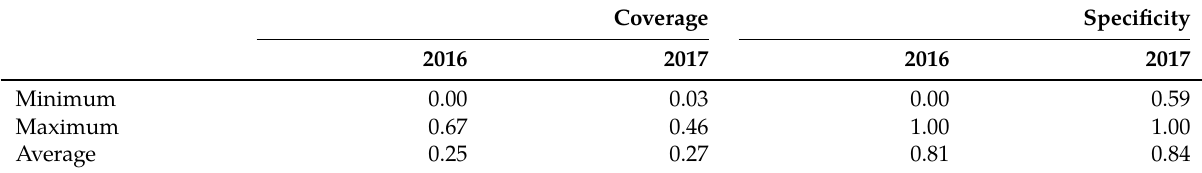
Table 1: The statistics for the two measurements of metadata quality in